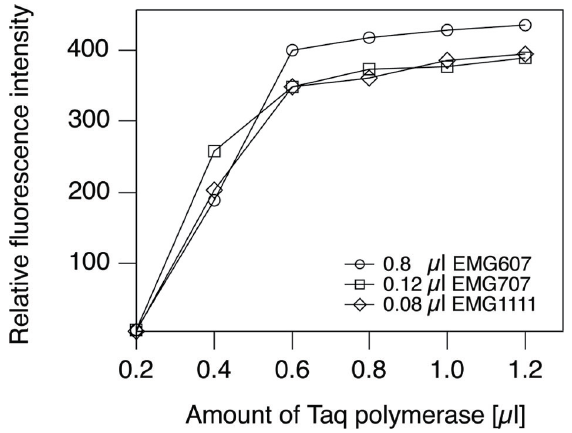
Figure 4. Dependence of PCR product yield with several types of magnetic nanoparticles at threshold concentration on amounts of Taq polymerase.